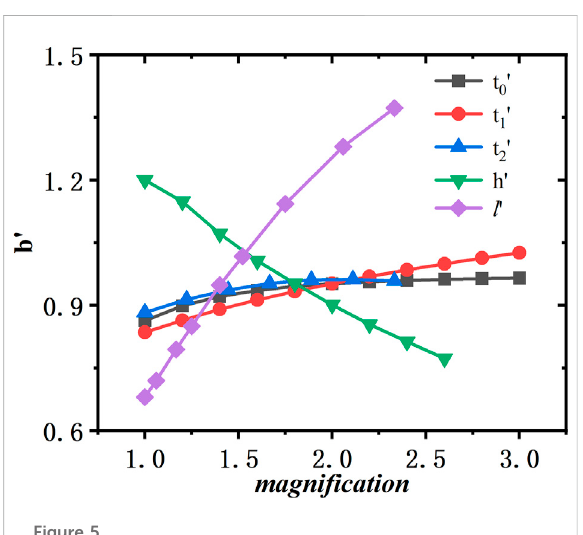
Figure 5 Variation dimensionless ribband width with parameter magni fi